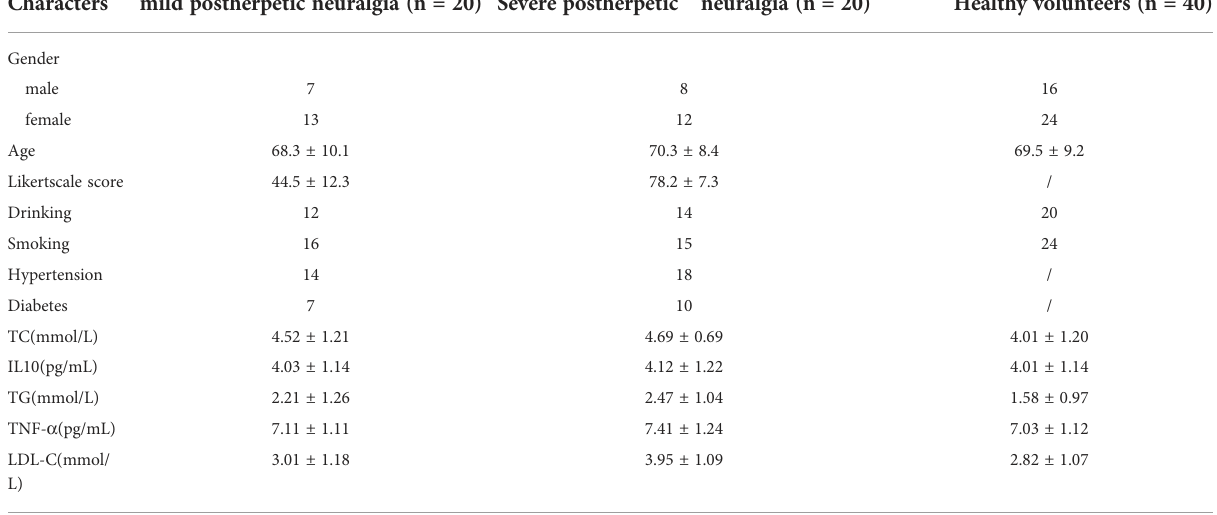
TABLE 1 The detailed clinical information of patients in postherpetic neuralgia and healthy volunteers.